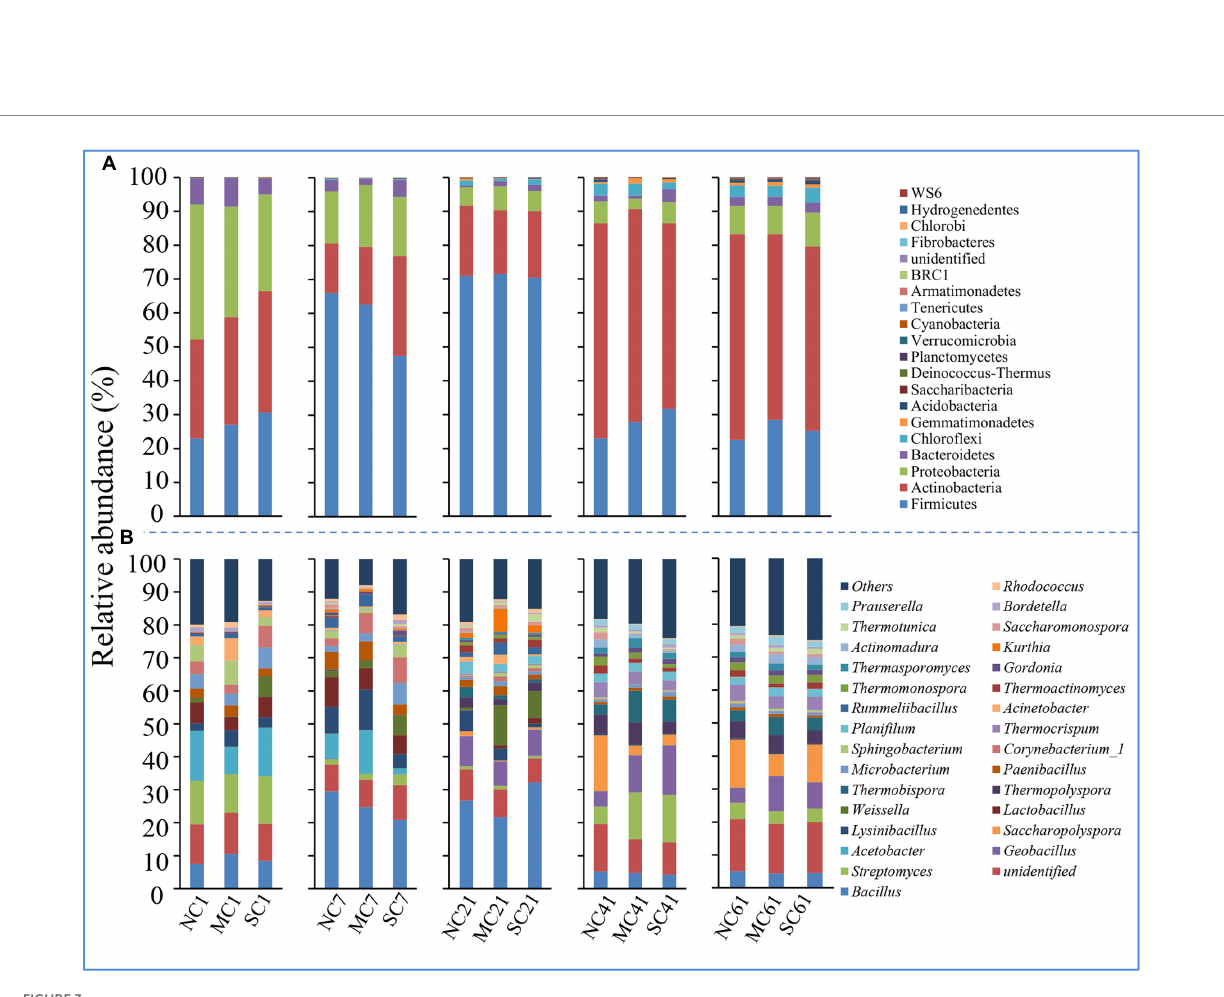
FIGURE 3 Relative abundance of bacterial species at the phylum (A) and genus (B)